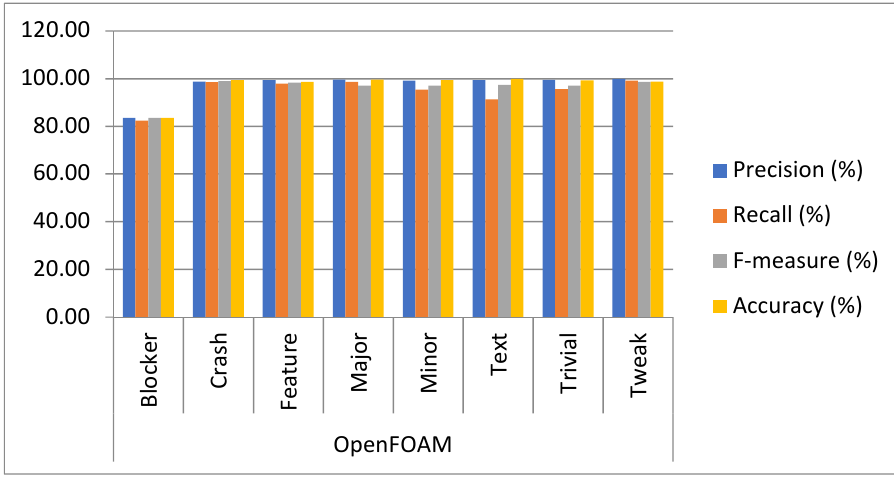
Figure 8. Results analysis of the proposed BCR on seven classes of the Jboss Project.